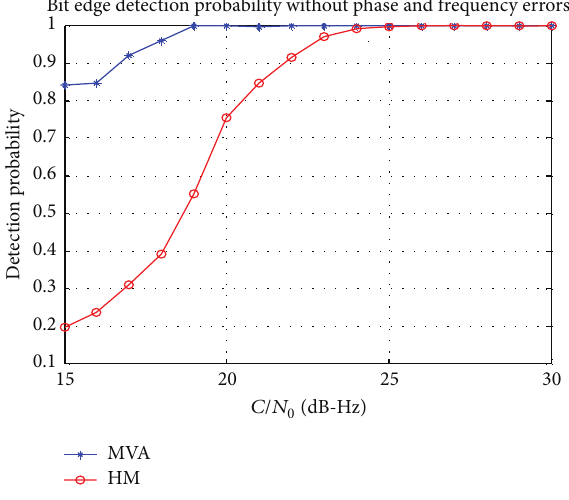
Figure 4: Without phase and frequency errors.